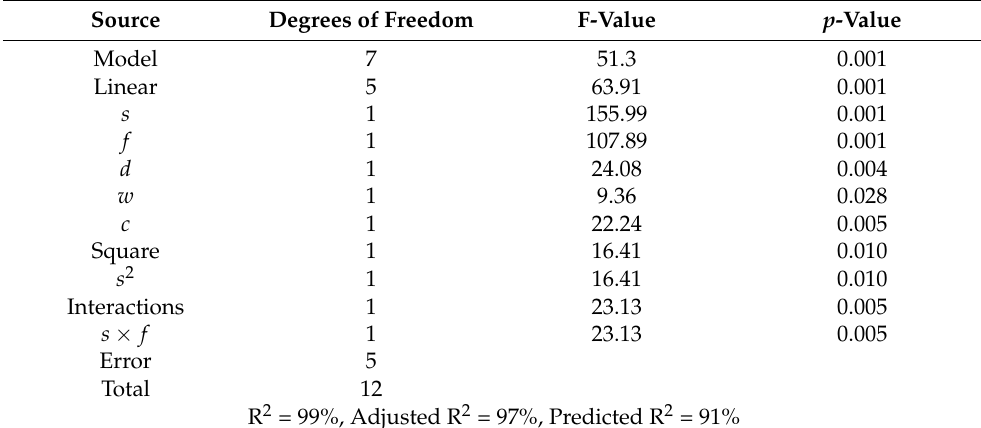
Table 6. Regression analysis of variance for tool wear.